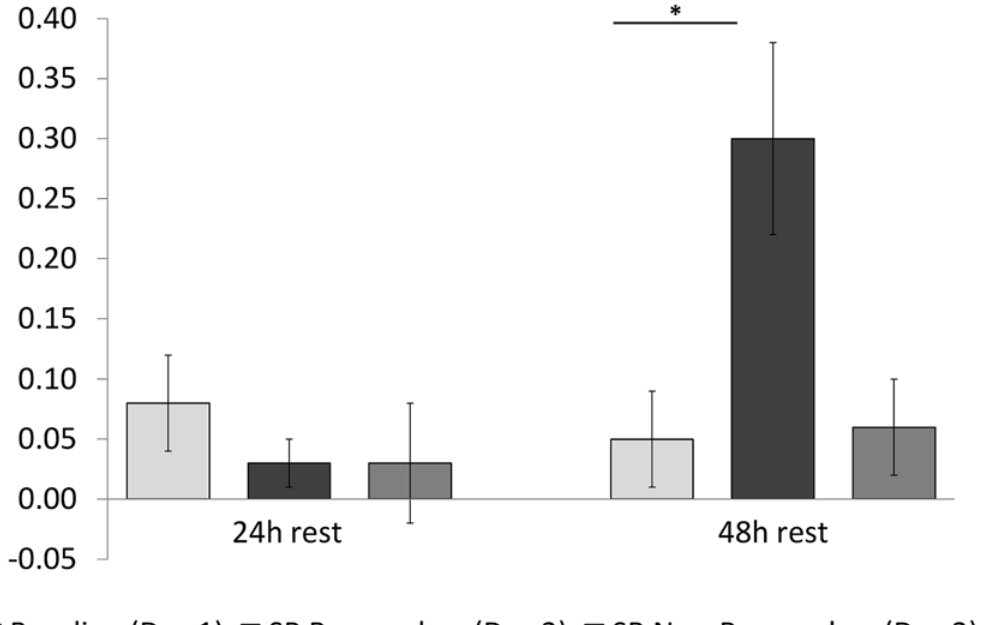
Fig 2. Plasticity of spatial repellency behaviors. Weighted spatial activity index (SAI) scores for cohorts of Aedes aegypti females exposed to 1.35mg/m 3 transfluthrin. After observing baseline (Day 1) behaviors, test mosquitoes were re-assayed on a subsequent day following either 24 or 48 hours of resting. * indicates a day 2 SAI significantly different than the baseline day 1 SAI, P <